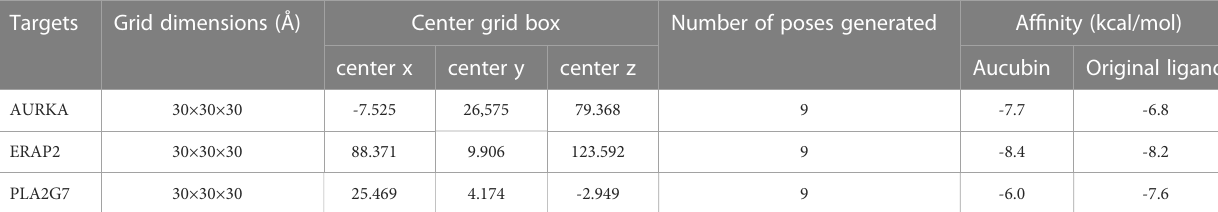
TABLE 3 Summary of molecular docking details.